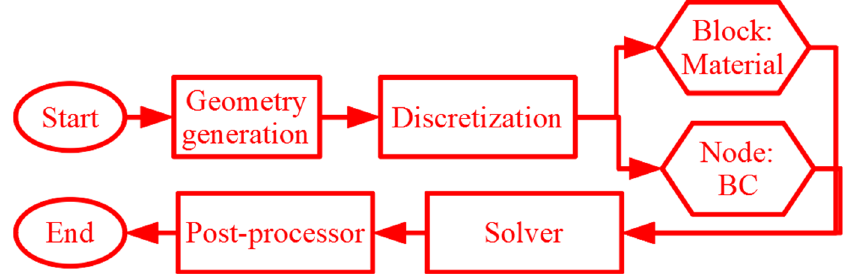
Figure 1. A schematic framework for peridynamics-based micromechanical modeling.